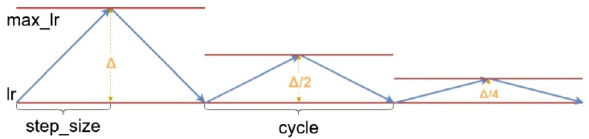
Figure 3. Triangular cycle decreases the cycle amplitude by half after each period, while keeping the base lr constant (this figure was created with Draw. io).